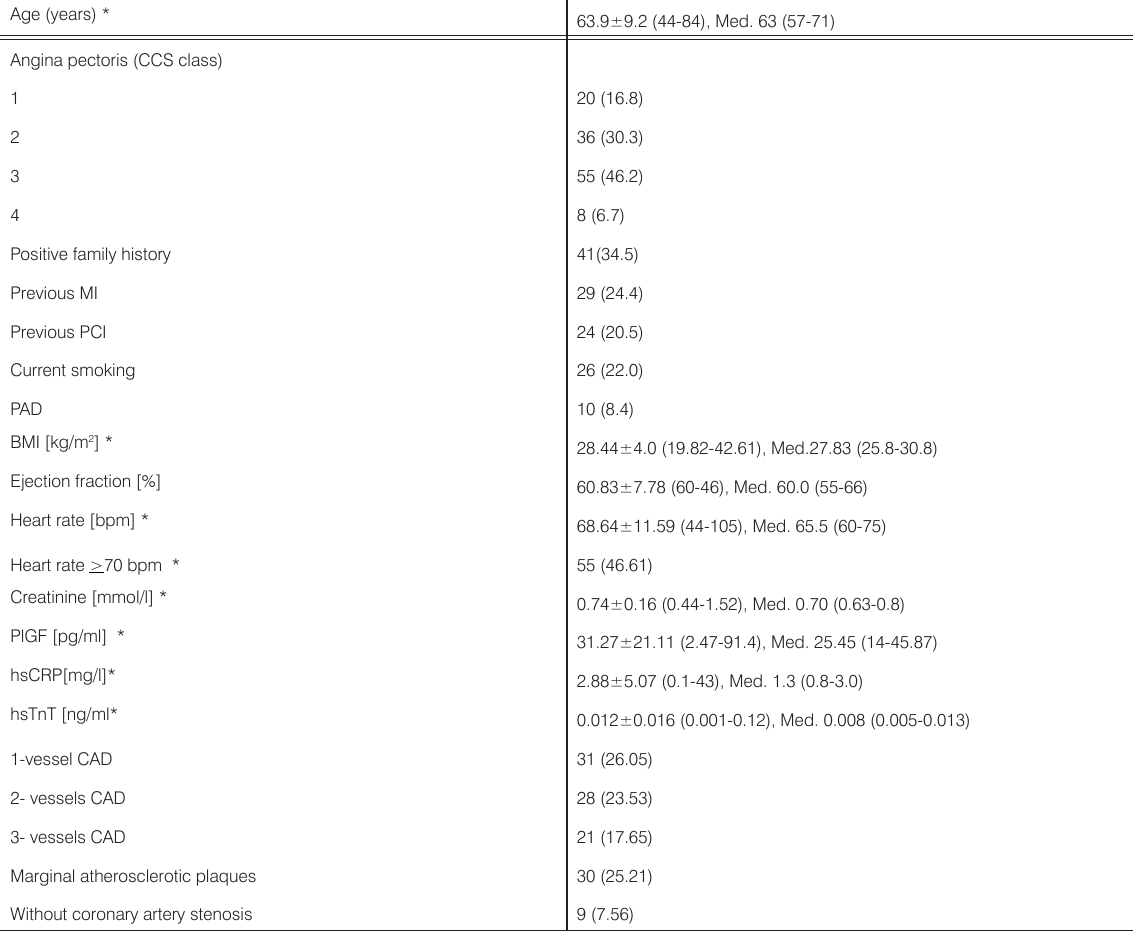
Table 1. Characteristic of the studied